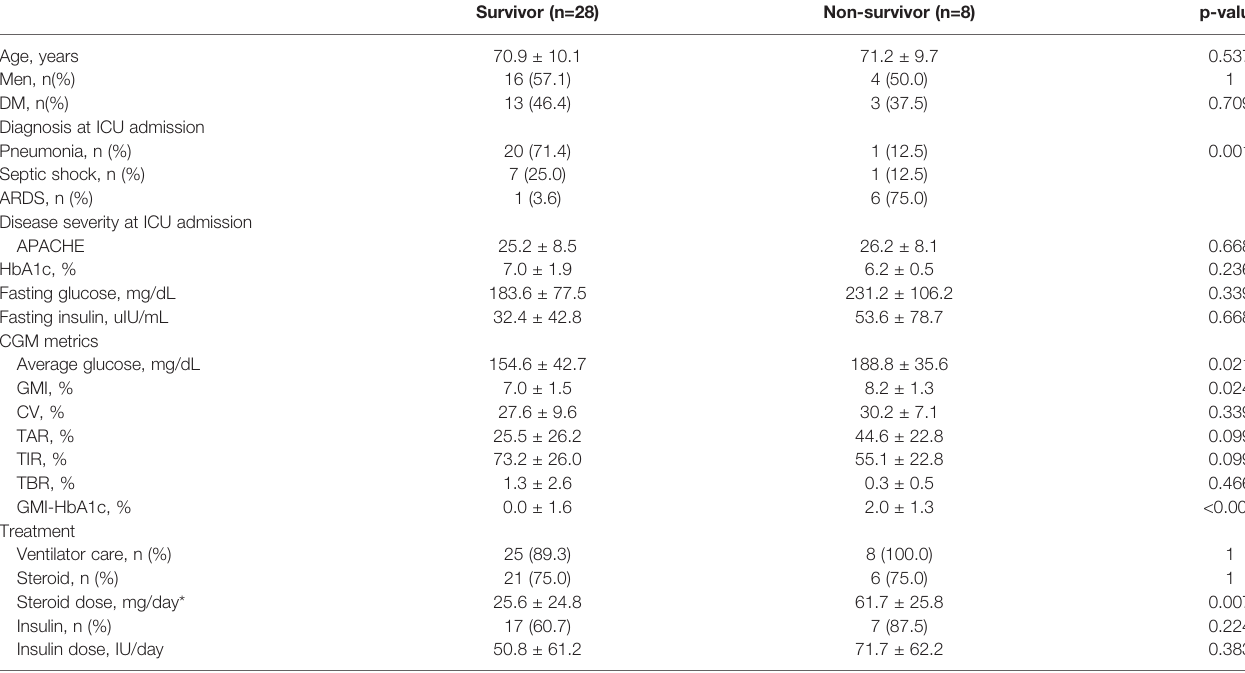
TABLE 3 | Comparison of characteristics according to mortality within 28 days.